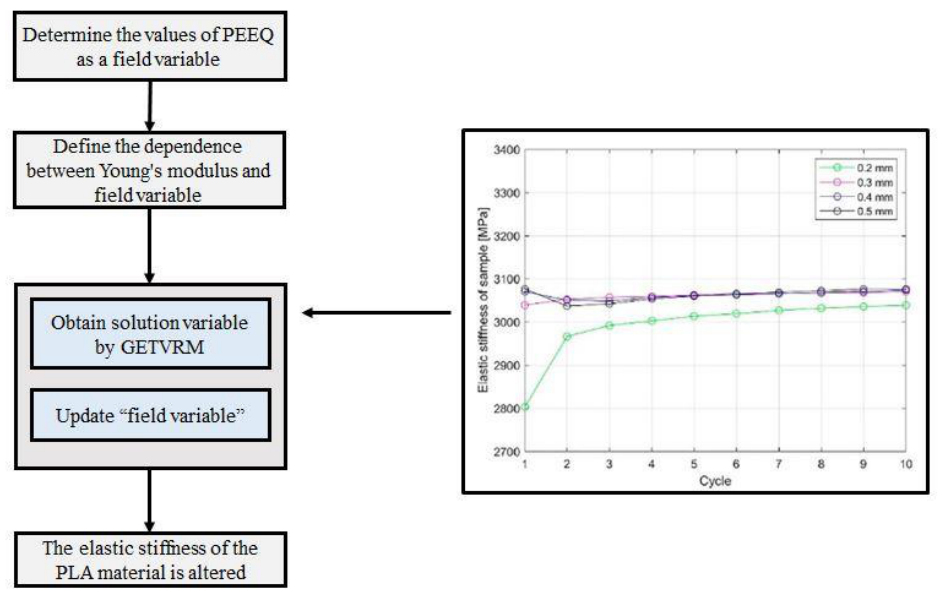
Figure 3. The chart for altered ES as a function of PEEQ ( left ) and the dependency of the elastic stiffness of the sample on the constitutive cycles and the loading path for 2.4 mm ILD considering at an initial tool displacement of 0.2 mm [35] ( right ).